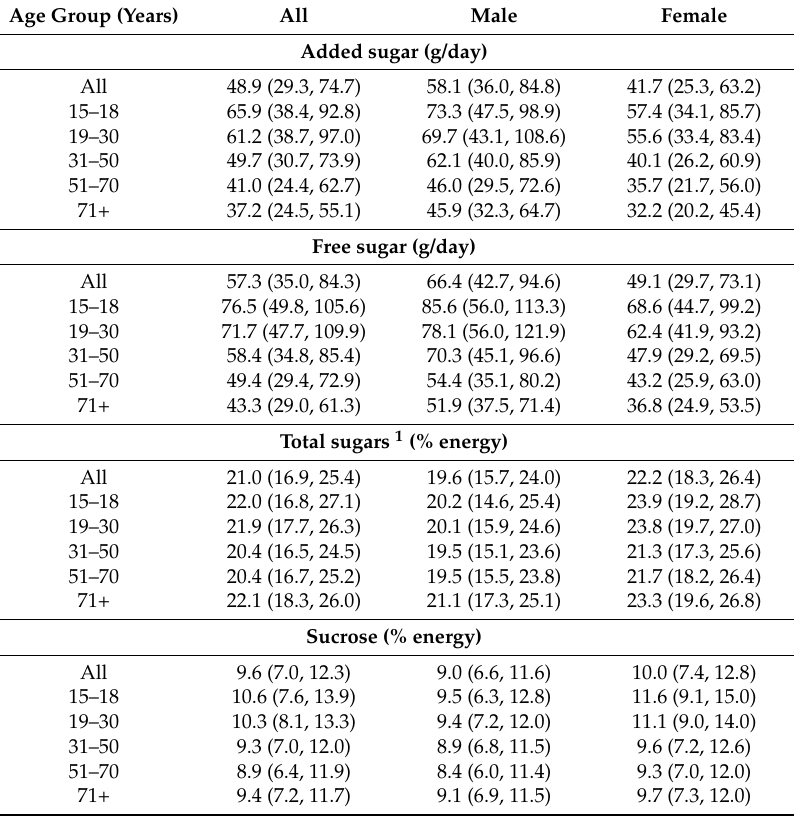
Table 2. Sugar intakes in New Zealand adults aged 15 years and older in 2008/09 by sugar category, age, and sex (median (25th, 75th